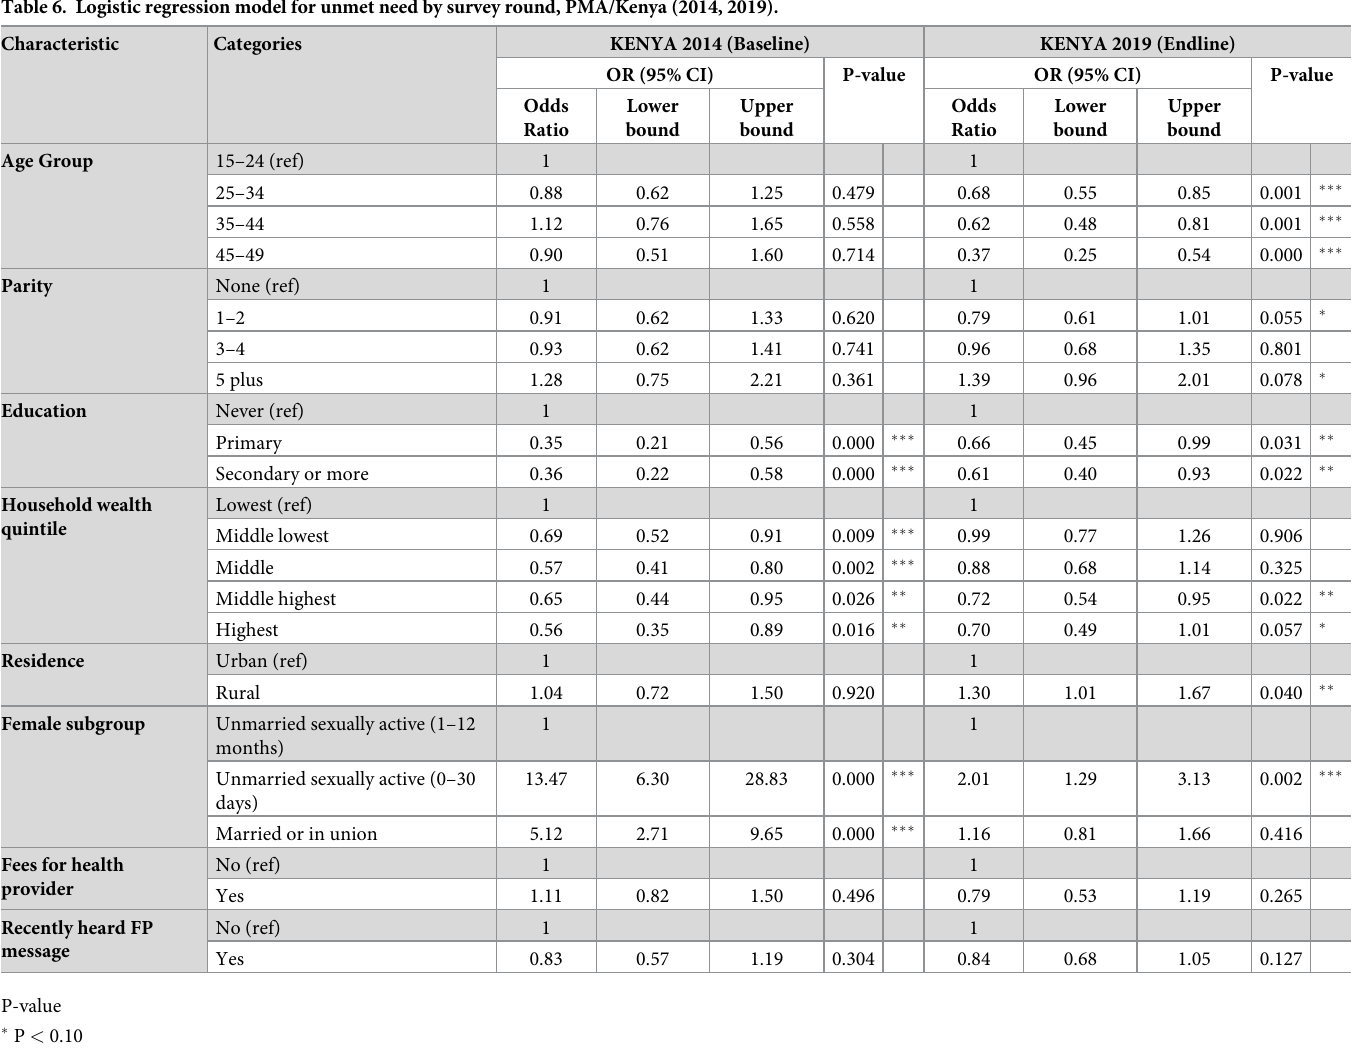
Table 6. Logistic regression model for unmet need by survey round, PMA/Kenya (2014, 2019). Characteristic Categories